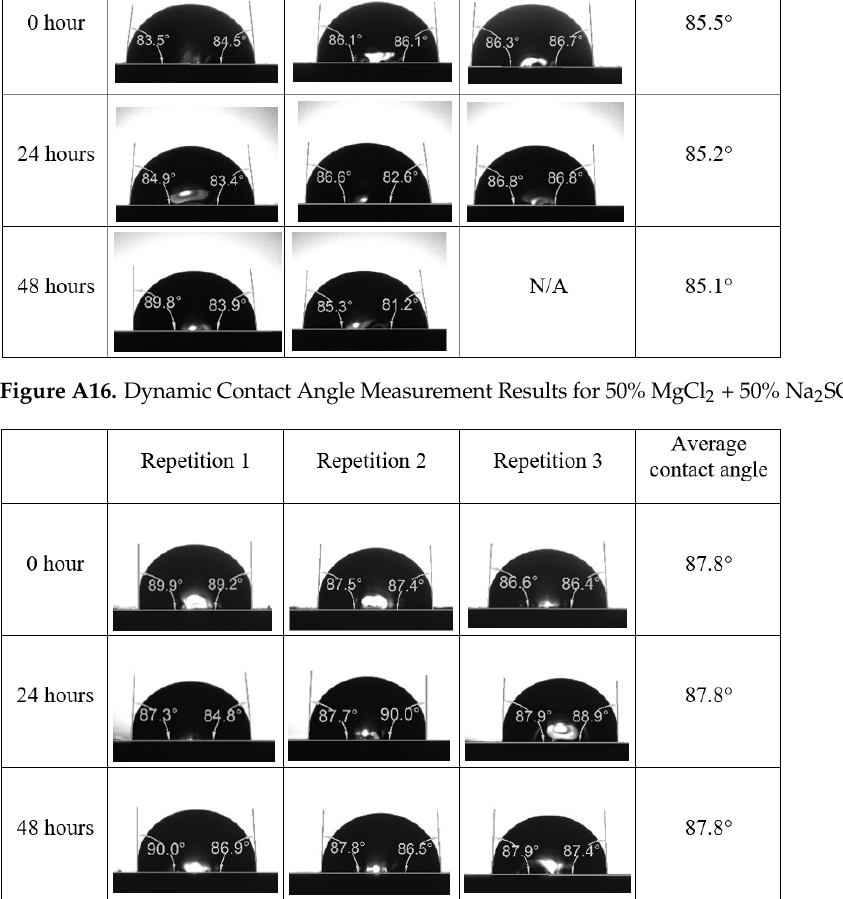
Figure A17. Dynamic Contact Angle Measurement Results for 75% MgCl 2 + 25% Na 2 SO 4 (3500